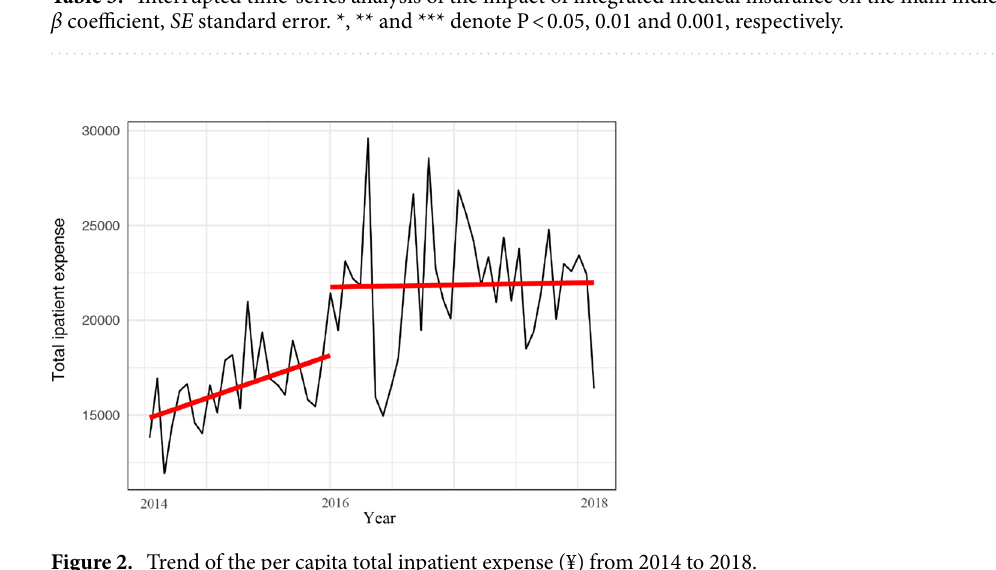
Figure 2. Trend of the per capita total inpatient expense (¥) from 2014 to